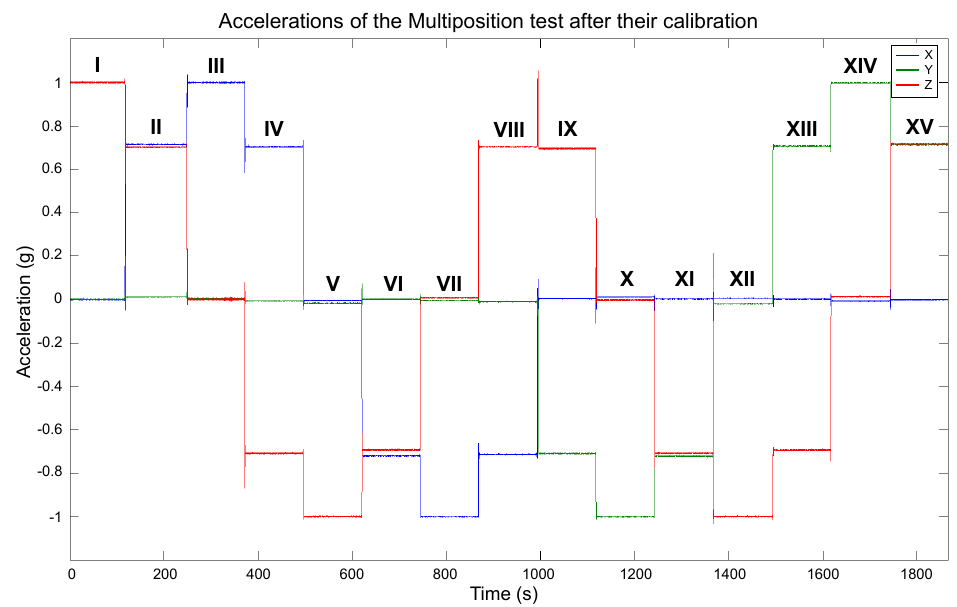
Figure 16. Measurements of the sensor rotation with the polyhedron after their calibration. Magnitude of the calibrated measurements 1.2